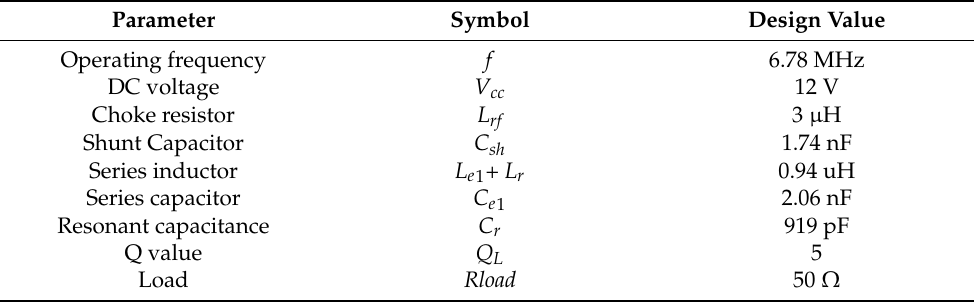
Table 4. Parameters of S-CPT based on the design and measurement values.